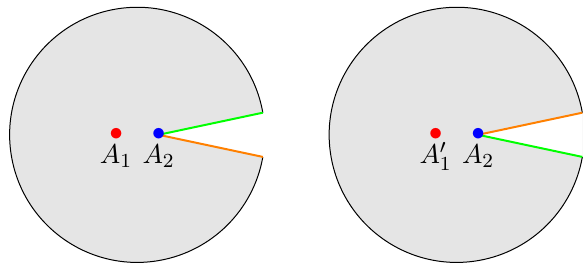
Figure 4 . Using the same projection as for the n = 1 figure at left in figure 3, we show two pieces of a corresponding saddle that for A 1 6 = A 0 describes an off-diagonal contribution to the second 1 Rényi entropy S 2 . The full saddle is constructed by sewing the two pieces together along edges of the same color; i.e., we may first identify the two green edges and then identify the two orange edges. Note that this particular saddle contains only one copy of the surface γ 2 and so cannot be ‘off-diagonal’ in A 2